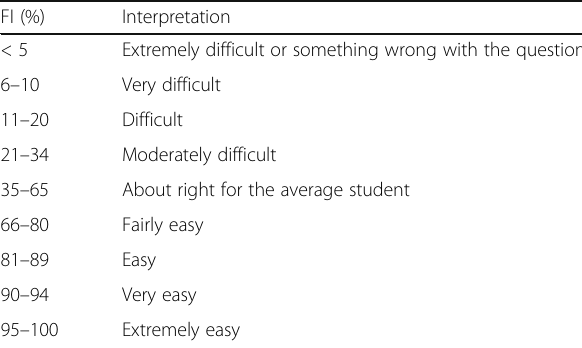
Table 1 Interpretation of FI (facility index values) of each question (adapted from Moodle Statistics, 2019a) FI (%) Interpretation